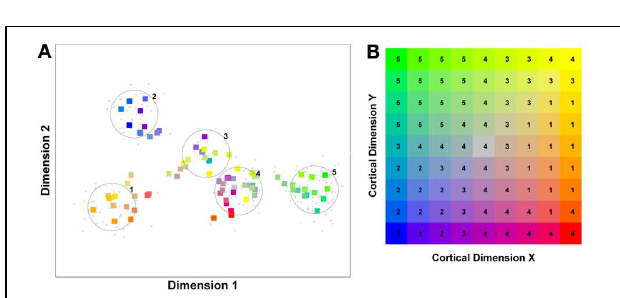
FIGURE 13 | Selectivity preferences for 81 neurons exposed to five object categories. The classifiers were subject to moderate local lateral excitation ( h = 0 . 3), but otherwise the simulation parameters were identical to those shown in Figure 12 . Notice in this case that there is evidence for emerging structure in neural selectivity, i.e., object category and physical location are now loosely related. (A) Neural selectivity within object space. (B) Neural selectivity across the cortical